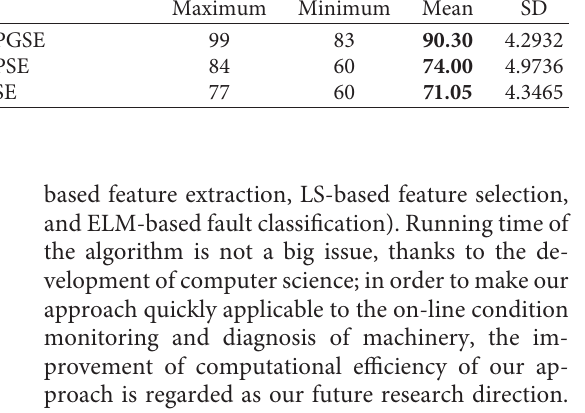
Figure 32: The plotting of the two randomly selected features in case 2. (a) MPGSE, (b) MPSE, and (c) MSE. Table 12: Diagnostic results of different methods without LS feature selection in case 2. Diagnostic accuracy obtained Different methods